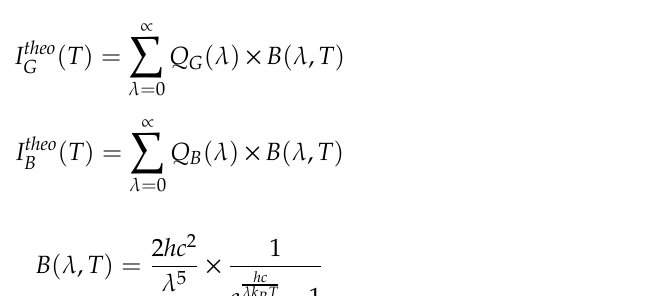
Figure 5. Schematic illustration of temperature measurement on the surface along the keyhole wall.